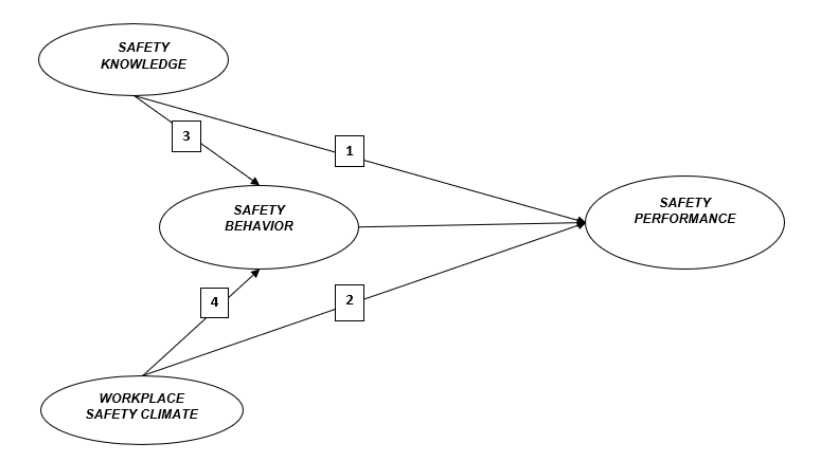
Figure 1: Research Framework and